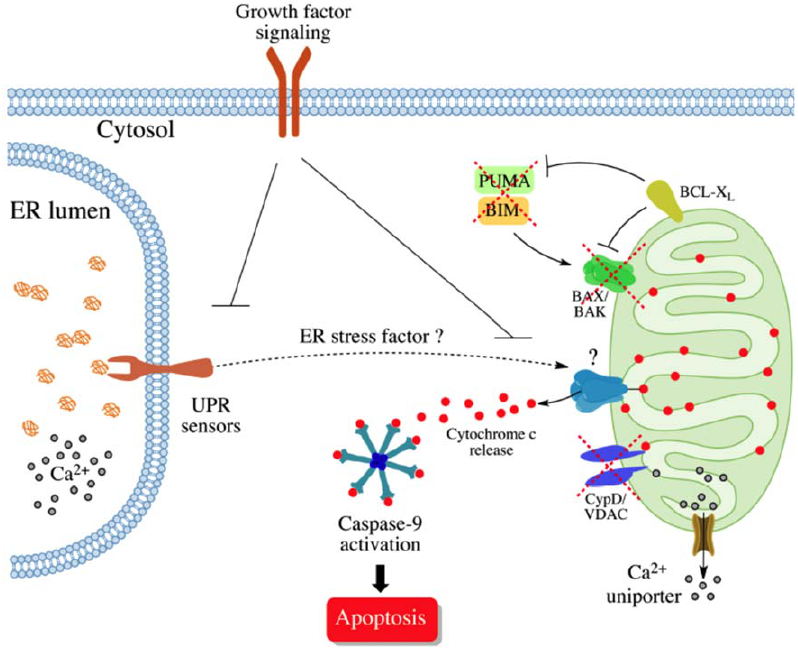
Figure 7. Working model: A BAX/BAK and CypD-independent intrinsic apoptosis pathway. ER stress-induced apoptosis is mediated by the activation of BAX and BAK at the mitochondria through upregulation of the upstream BH3-only proteins (i.e. BIM and PUMA) leading to mitochondrial outer membrane permeabilization, cytochrome c release, and subsequent apoptosome assembling. Under certain conditions such as mitochondrial calcium overload and oxidative stress, cytochrome c release can occur independently of BAX and BAK through opening of the mitochondrial permeability transition pore (PTP), which is form by several components including CypD and VDAC. Opening of the PTP leads to the expansion of the mitochondrial matrix, resulting in sufficient swelling to rupture the outer mitochondrial membrane and cytochrome c release. Stimulation of ER stress in conjunction with mild serum withdrawal triggers apoptosis in a BAX/BAK and CypD-independent manner. This alternative death pathway is mediated by the activation of caspase-9. Under normal conditions growth factor signaling may inhibit this alternative cell death pathway at the level of (i) mitochondria, or by (ii) blocking the activation of a specific ER-dependent event.